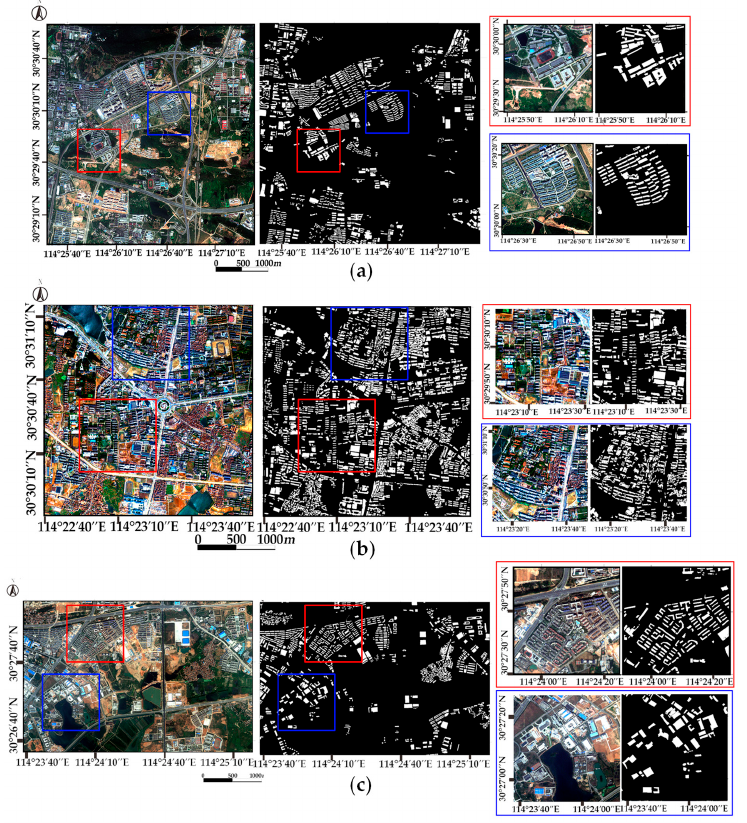
Figure 5. Three test datasets and the corresponding ground truth maps: ( a ) Dataset 1 and Subgraphs I1 (in the red box) and I2 (in blue box); ( b ) Dataset 2 and Subgraphs I3(in the red box) and I4 (in the blue box); ( c ) Dataset 3 and Subgraphs I5 (in the red box) and I6 (in the blue box).